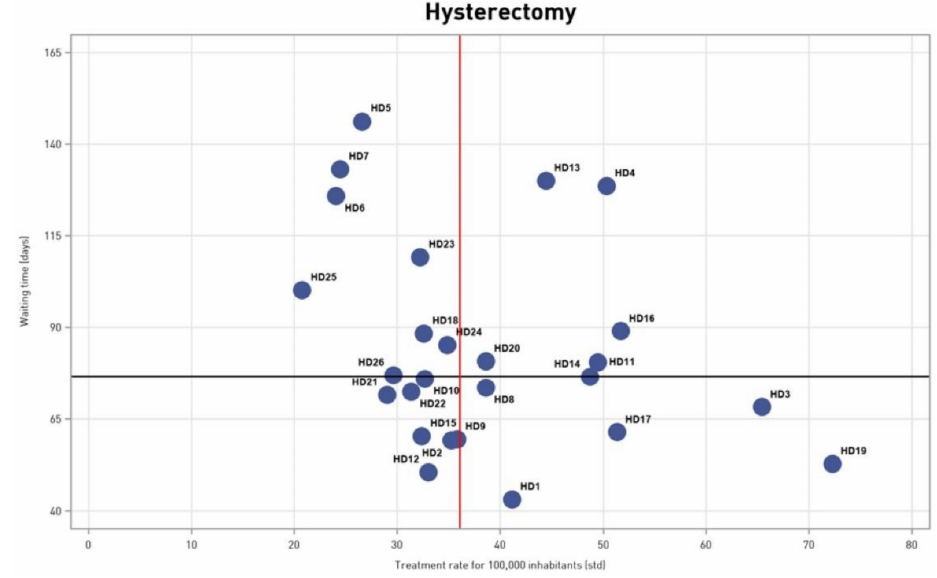
Figure 1. Waiting times and treatment rates for 100,000 inhabitants (std)—2018,